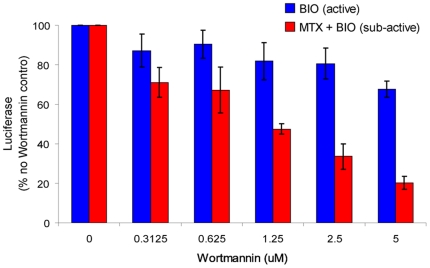
Methotrexate enhancement of BIO-mediated BAR activation is blocked by the PI3K inhibitor Wortmannin.RKO-BAR cells treated with either suboptimal BIO (312 nM) plus methotrexate (red bars), or with an active concentration of BIO (1.5 µM, blue bars), were exposed to a titration of Wortmannin, and luciferase activity was measured 24 h following exposure to drug. Consistent with a requirement for PI3K signaling to mediate the synergistic interaction between DHFR and GSK3 inhibitors, wortmannin significantly reduced BAR activity induced by the combination of the two inhibitors in a dose dependent manner. In contrast wortmannin had modest effect on BAR activity induced by the active dose of BIO alone. Results represent the mean±SD of three replicate wells for each sample.